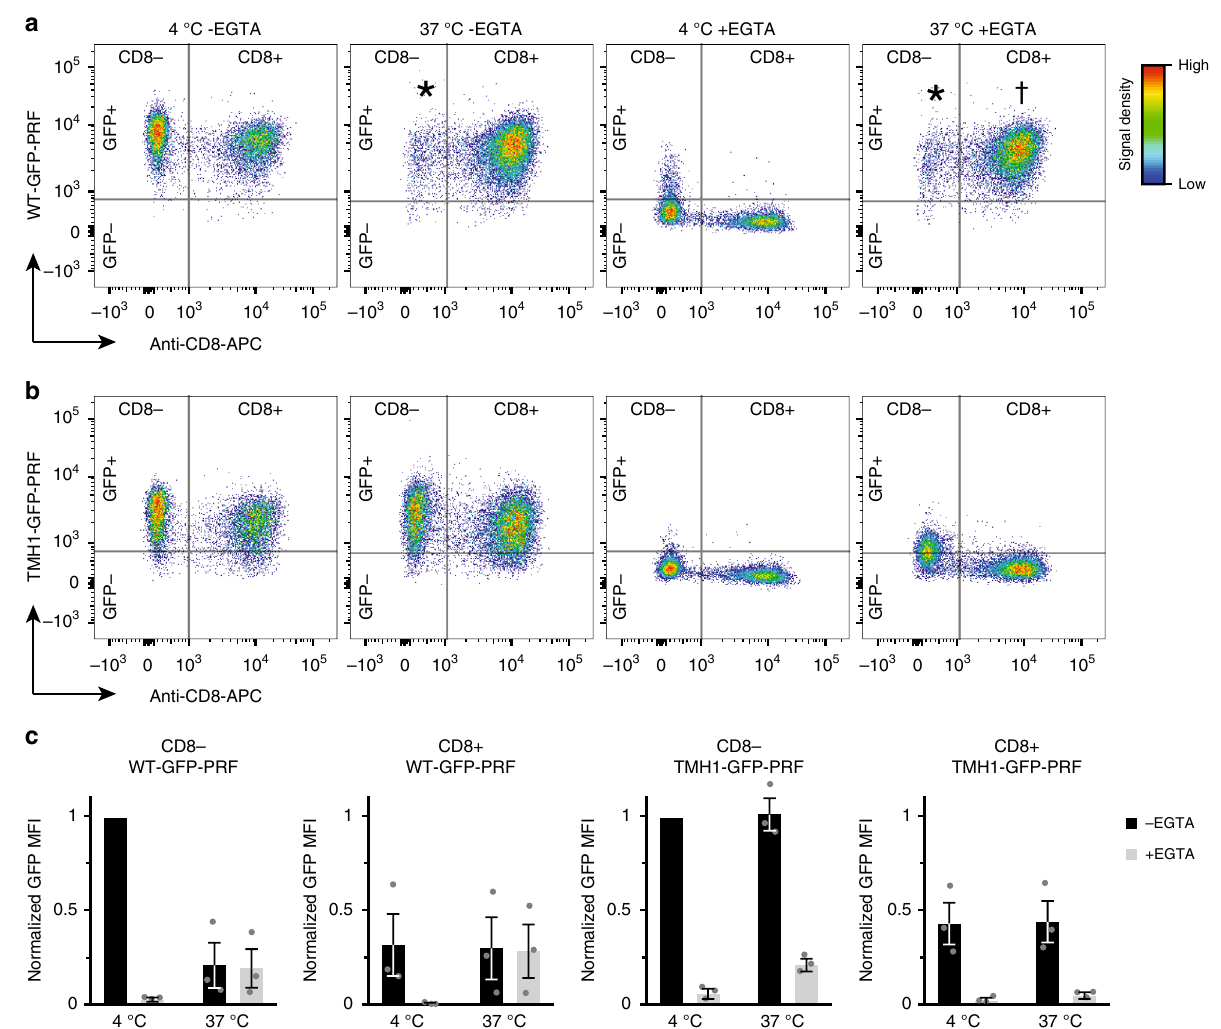
Fig. 2 Residual perforin bound to CTLs is deactivated. a Binding of WT-GFP-PRF to EL4 (CD8 − ) and CTL (CD8 + ) cells, at concentrations that are sub-lytic to CTLs, as assessed by fl ow cytometry. At 4 °C and in the presence of Ca 2 + ( − EGTA), both cell types bind perforin (GFP + ), but the CTLs at a lower level than EL4 cells. At 37 °C and in the presence of Ca 2 + ( − EGTA), WT-GFP-PRF is lytic to the EL4 cells, so no signi fi cant CD8 − population remains under those conditions (asterisks). Upon subsequent Ca 2 + chelation by 2 mM EGTA, non-porating perforin assemblies (WT-GFP-PRF at 4 °C) are removed from the cell membranes (GFP − ). However, Ca 2 + chelation does not affect WT-GFP-PRF bound to CTLs at 37 °C (GFP + , dagger), despite WT-GFP-PRF being apparently non-porating (see Fig. 1c). b Binding of non-lytic TMH1-GFP-PRF to EL4 (CD8 − ) and CTL (CD8 + ) cells, as assessed by fl ow cytometry. In the presence of Ca 2 + ( − EGTA), TMH1-GFP-PRF binds to both cell types, but less to CTLs, as observed for WT-GFP-PRF. Upon subsequent Ca 2 + chelation by 2 mM EGTA ( + EGTA), TMH1-GFP-PRF is invariably removed from the cell membranes, leaving only GFP − populations (both at 4 °C and 37 °C). c Quanti fi cation of fl ow cytometry results, with MFI of WT-GFP-PRF and TMH-GFP-PRF signals, normalized to the respective MFIs for the CD8 − population at 4 °C. EGTA exposure drastically reduces the GFP MFI for all cases at 4 °C and for (non-lytic) TMH1-GFP-PRF at 37 °C. By contrast, WT-GFP- PRF is EGTA resistant once bound to CD8 + cells at 37 °C. Note that the low GFP MPI at 37 °C in the fi rst panel (CD8 − , WT-GFP-PRF) is due to the majority of the CD8 − cells being killed and thus not yielding a GFP signal in the fl ow cytometer anymore. The TMH1-GFP-PRF data ( − EGTA) allow for a quantitative comparison between binding to CD8 + and CD8 − cells, showing that the CTLs (CD8 + ) bind less than half as much perforin as the target cells (CD8 − ). Each column represents a mean (±s.e.m.) of three independent fl ow cytometry experiments. Source data for c are provided as a Source Data fi results show that the abnormal behaviour of perforin on PS membranes, i.e., the formation of non-porating assemblies, is due